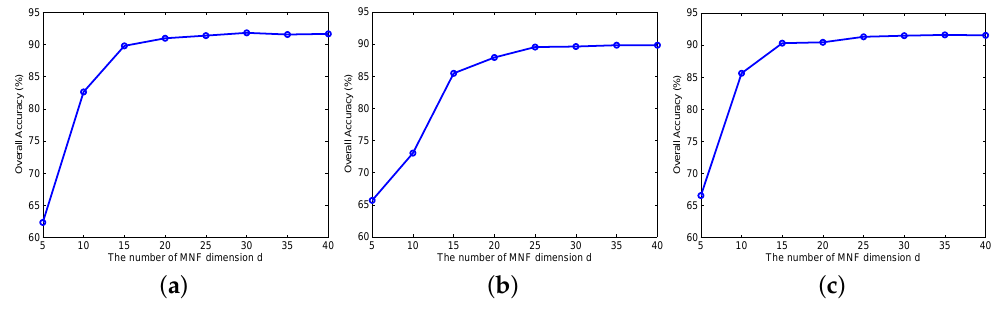
Figure 9. The OA versus the MNF dimension d : ( a ) IP; ( b ) UP; ( c )